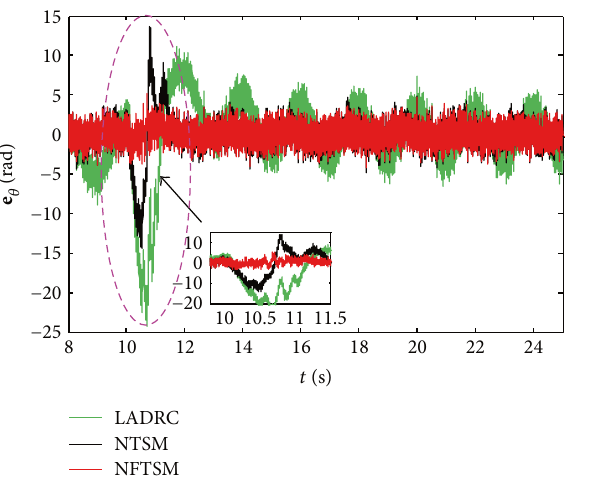
Figure 14: Angular velocity tracking errors by di ff erent schemes. Figure 12: Angular position tracking errors by di ff erent